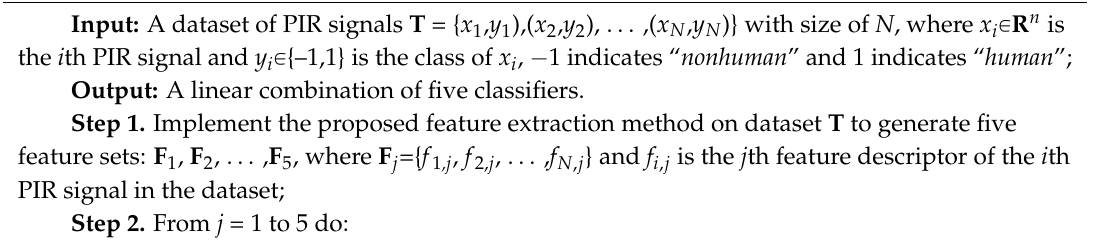
Algorithm 1. Voting weights determination procedure: